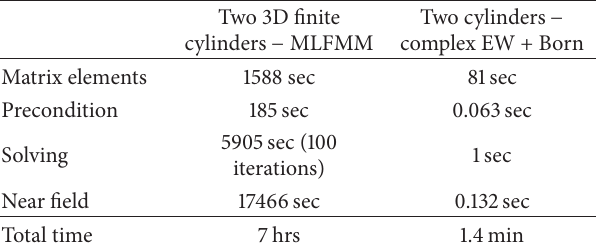
Table 2: Computation time summary for Figures 8(a) and 8(b).